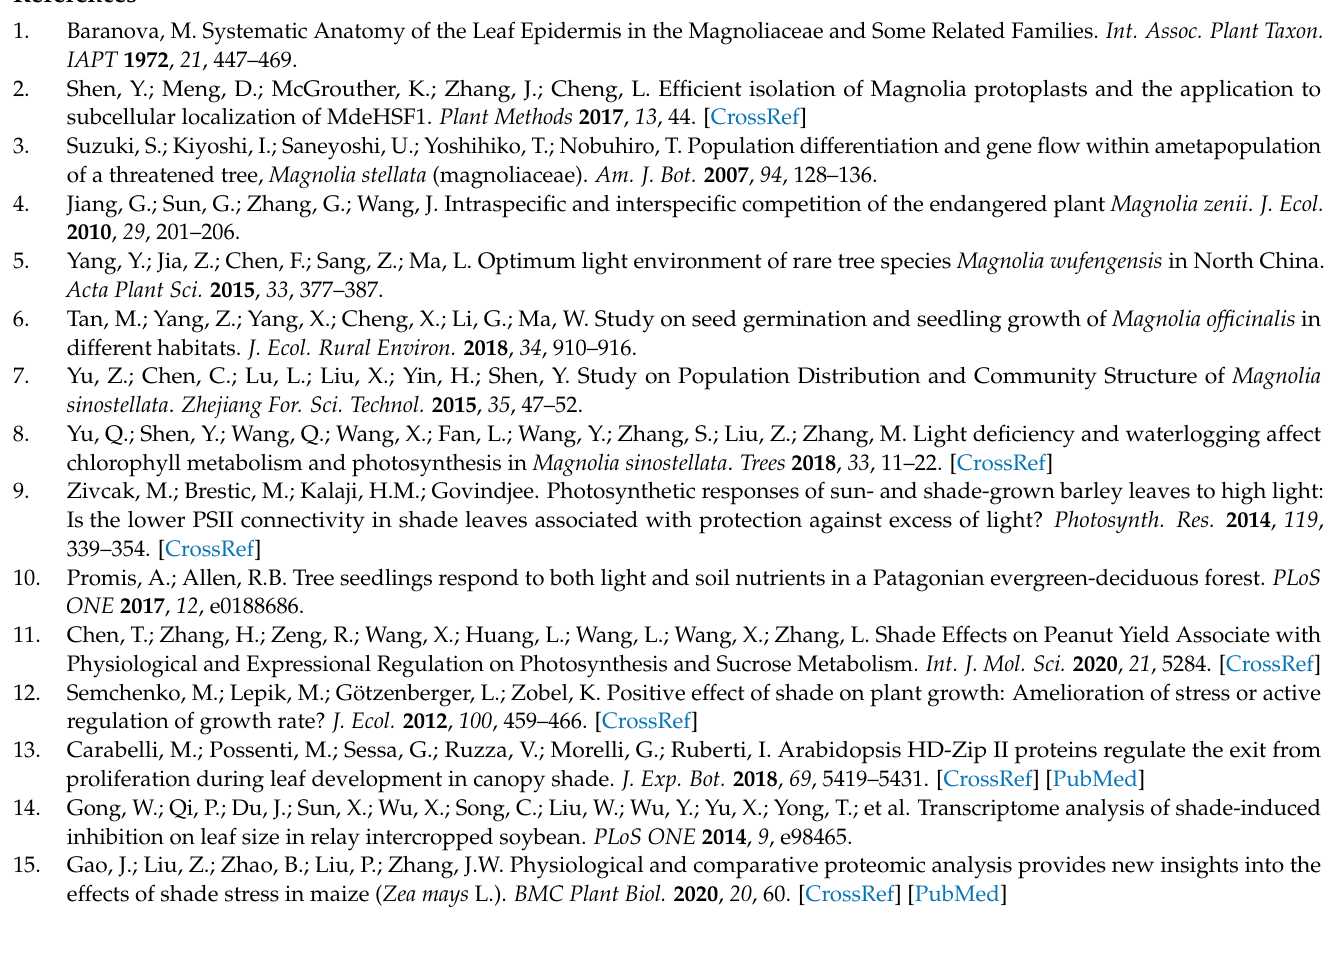
Figure S6: Shade responsive DEGs identified in M. sinostellata. (A) Number of DEGs detected in four comparison groups. (B) Venn diagram of DEGs commonly or specifically expressed in M. sinostellata under shade treatment, Figure S7: Shading treatment device used in this research, Table S1: Primers for quantitative real time PCR (RT-qPCR), Table S2: Summary of the final transcript sequence obtained after de-redundancy, Table S3: Summary of function annotation result statistics, Table S4: Summary of filtered read quality statistics, Table S5: Summary of reference gene sequence alignment results, Table S6: Information of TIFY gene family in M. sinostellata, Table S7: Information of mTERF gene family in M. sinostellata, Table S8: The light intensity and quality in different